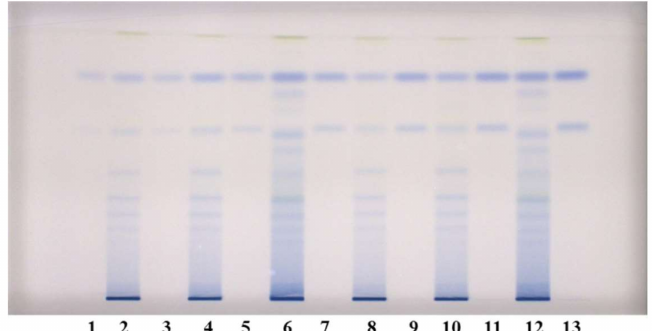
Figure 4. HPTLC chromatograms used for quantitative determination of proanthocyanidins in STSs from leaves (1 µ L, 50 mg / mL) of Japanese (tracks 2 and 8), Bohemian (tracks 4 and 10) and giant